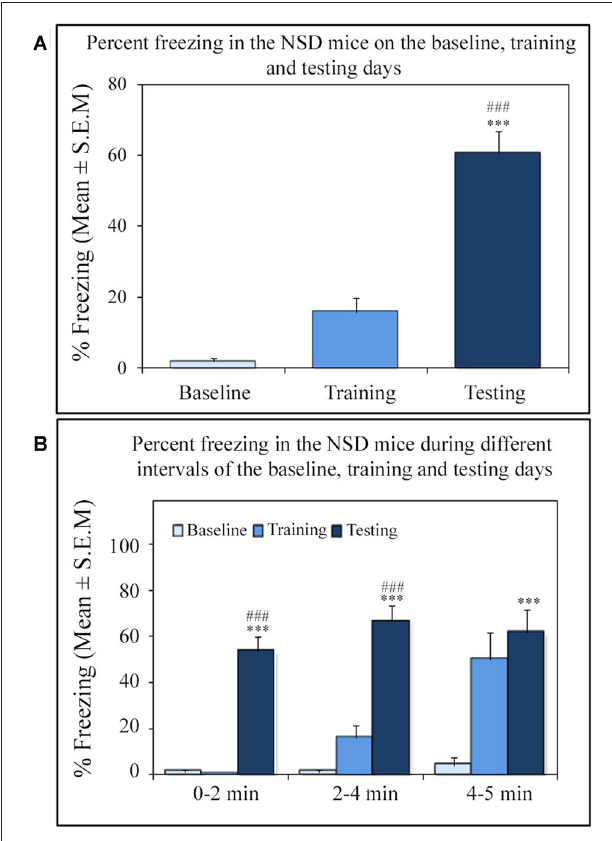
FIGURE 2 | The percent freezing response in Non-SD (NSD) animals on the baseline, training and testing days. (A) The NSD mice exhibited a significant increase in percent freezing ( p < 0.001; F ( 2,23 ) = 60.64) on the testing day (compared to baseline day: Tukey p < 0.001; compared to training day: